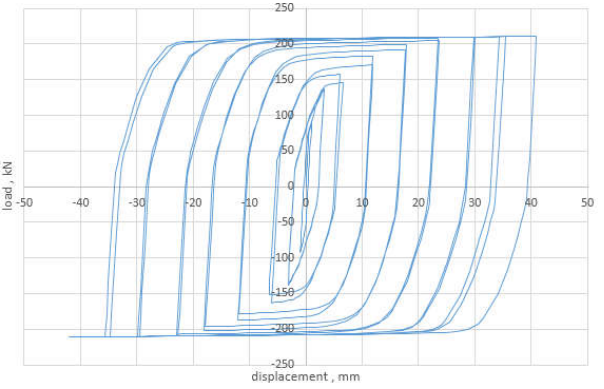
Figure 8. The hysteresis diagram of model.